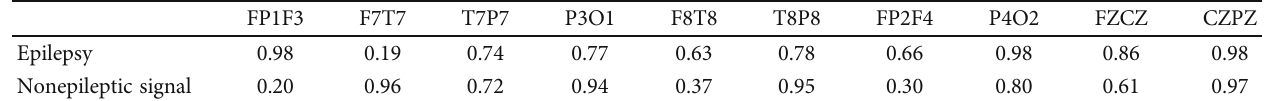
Table 5: Signi fi cance analysis of sample entropy before and after